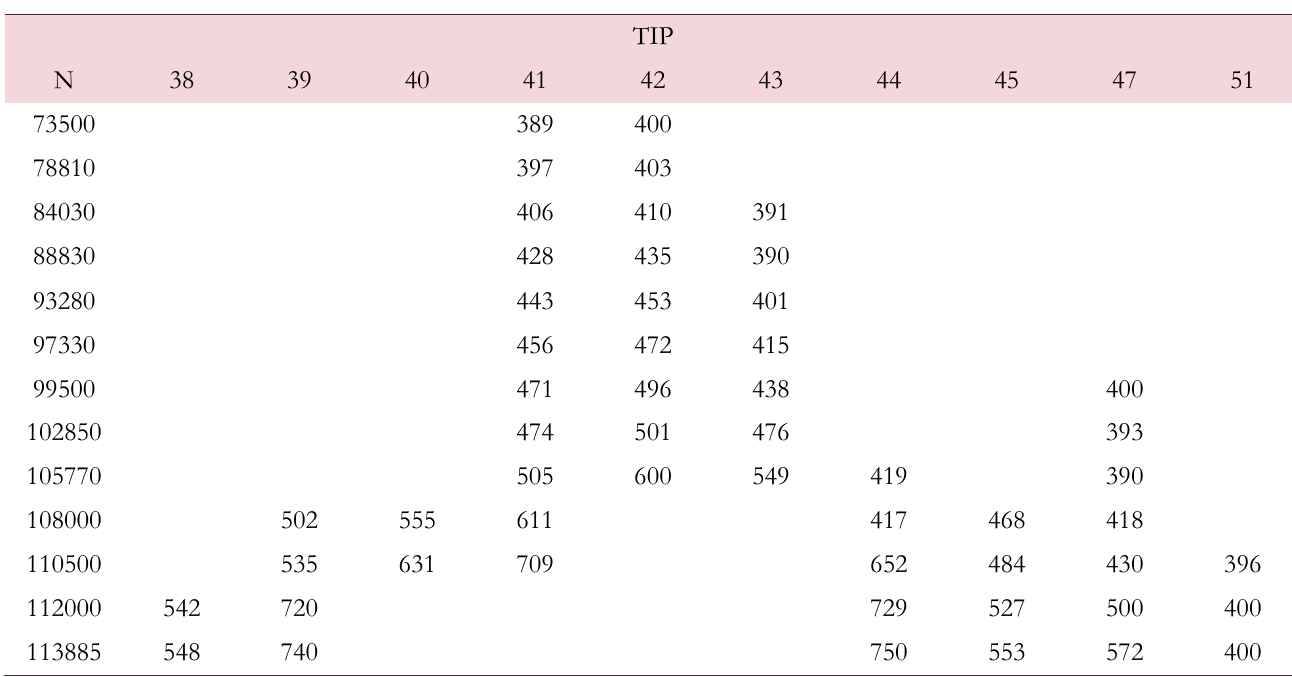
Table 2: Equivalent SIF’s (MPa  mm) versus number of